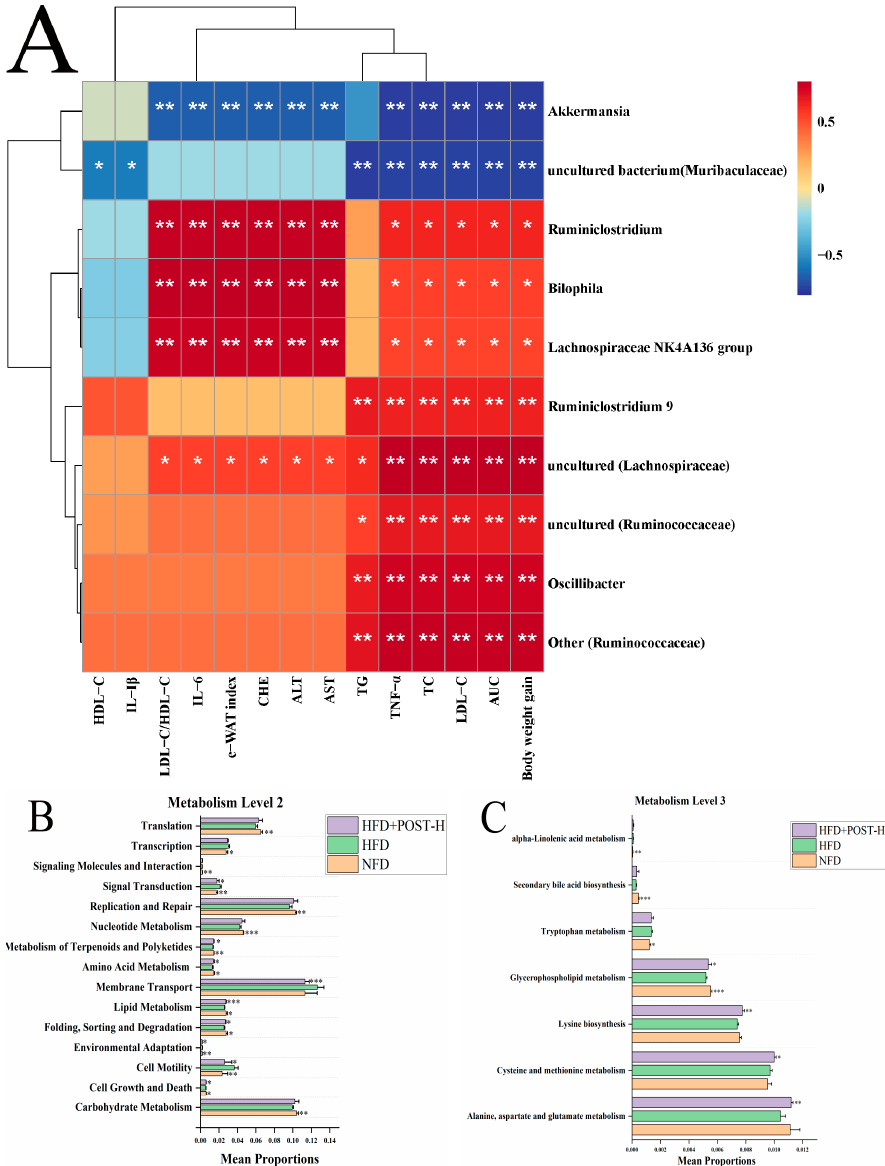
Figure 6. Correlation analysis ( A ) and microbial metabolic function of KEGG at level 2 ( B ) and level 3 ( C ). Correlation, blue for negative and red for positive, the asterisk represents the significance of the correlation value, * p < 0.05, ** p < 0.01. Compared to HFD, * p < 0.05, ** p < 0.01, and *** p < 0.001.